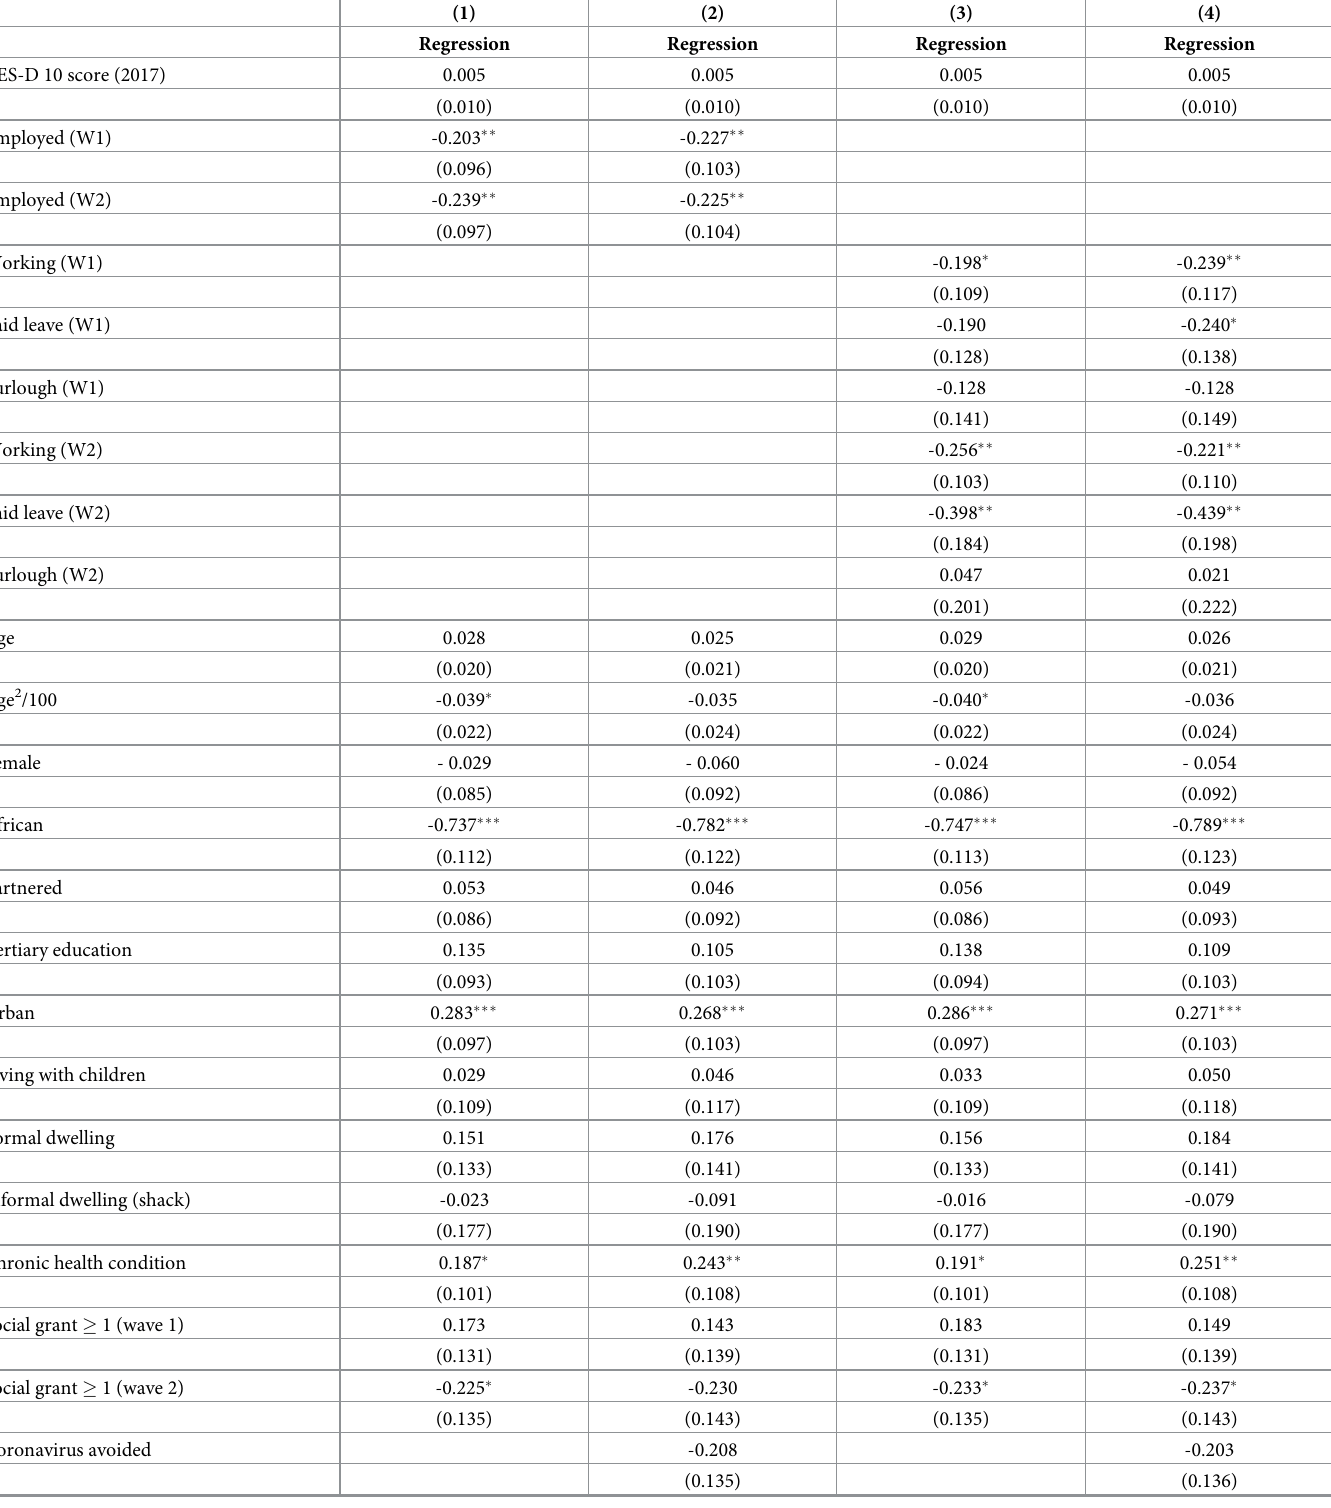
Table 2. Ordered logit regressions predicting PHQ-2, among those employed before